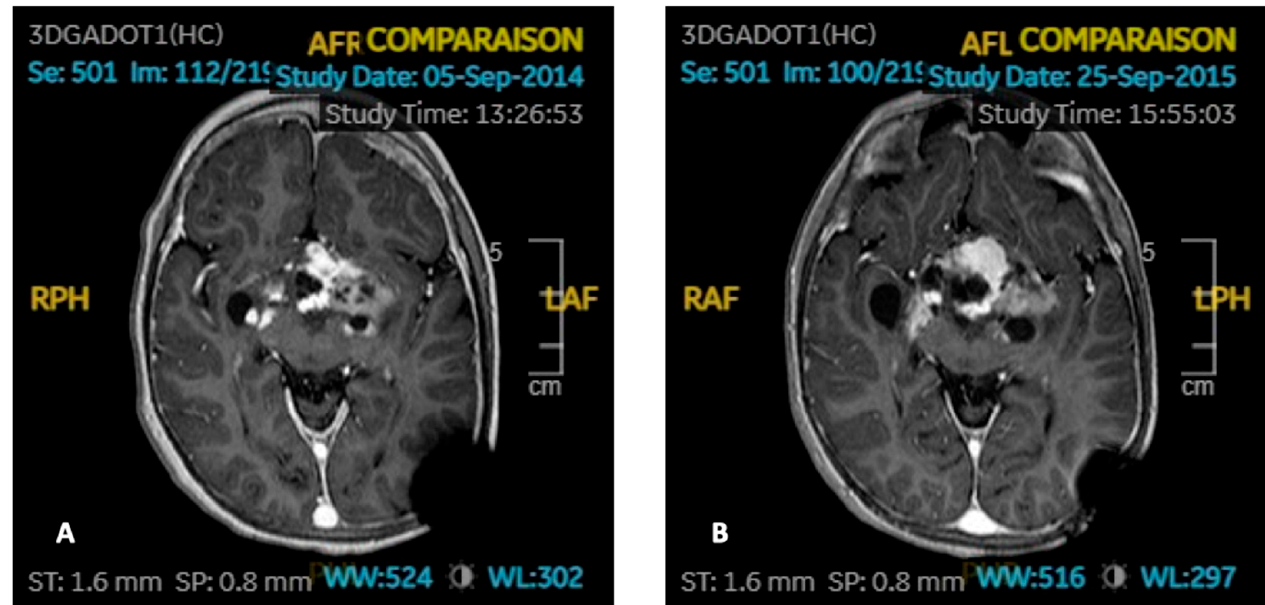
Figure 3. Imaging of Patient 91 with ganglioglioma (axial T1-weight with gadolinium). ( A ) Stable tumor residue before GHRT. ( B ) Progressive disease after 9 months of GHRT.